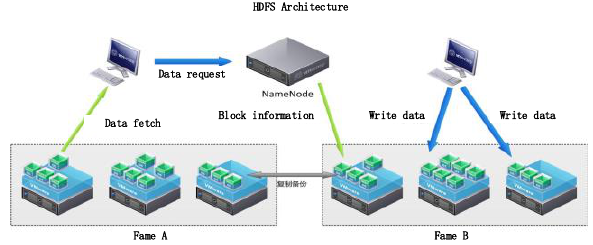
Figure 4 HDFS architecture